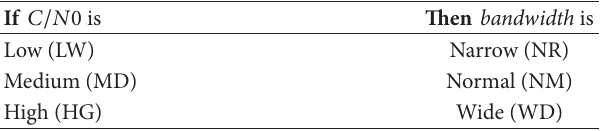
Table 1: Fuzzy rules for adaptive PLL